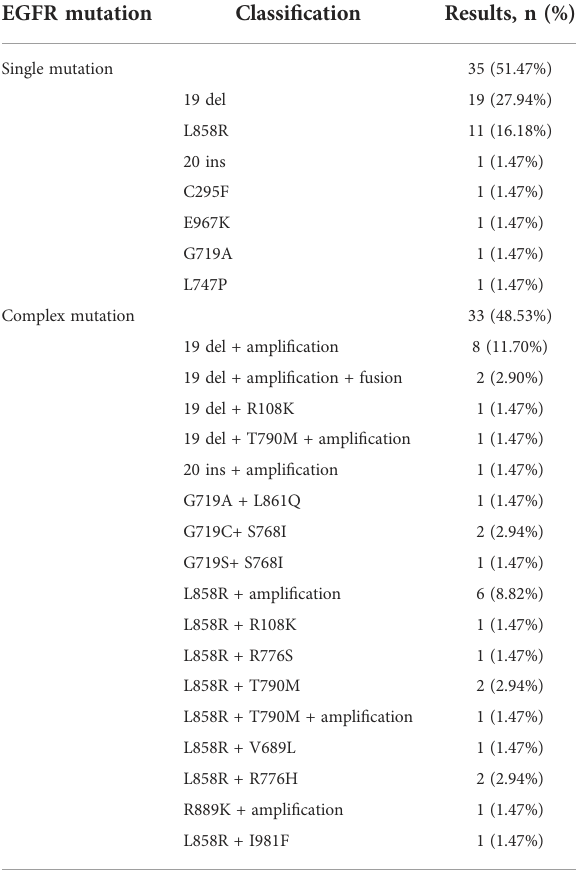
TABLE 2 EGFR mutation type in our